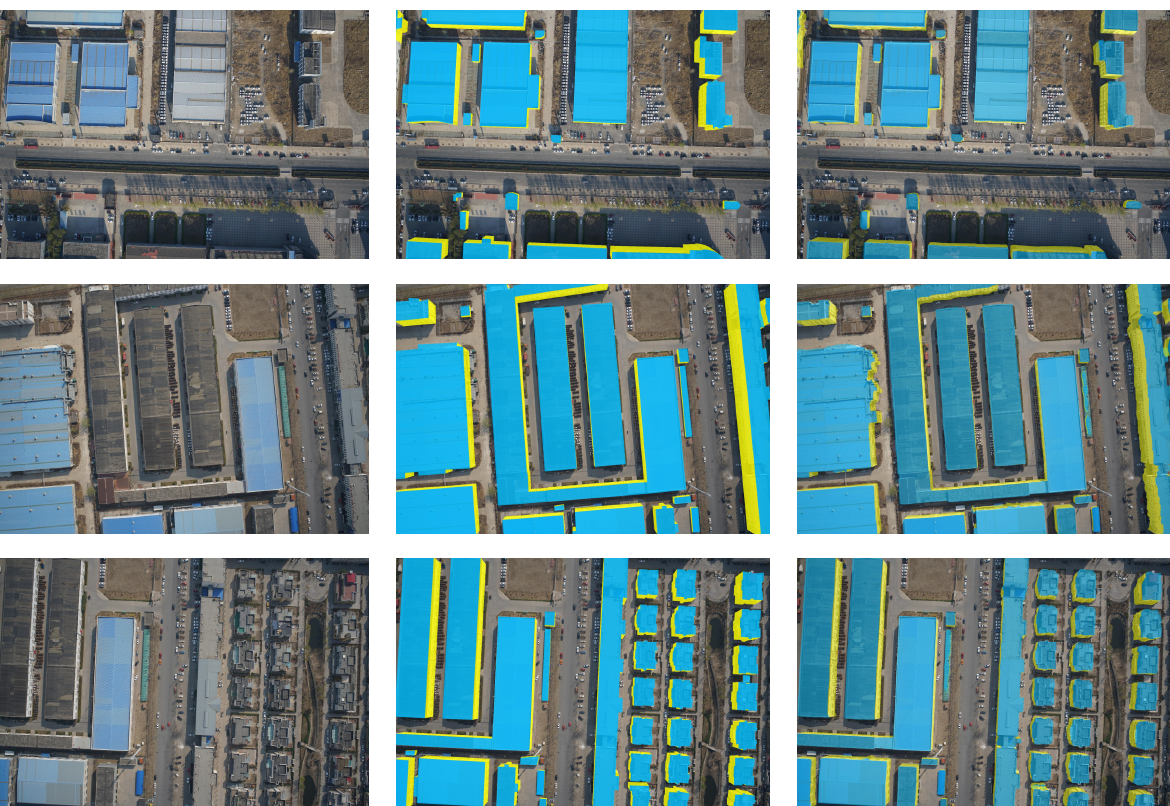
Figure 3. Samples of the reconstructed 3D buildings, which were projected on to the original aerial images. Left: the original aerial images, middle: the original aerial images covered with the projection masks of the building ground truth, right: the original aerial images covered with the reconstructed 3D building masks from our method. The light-cyan masks color the roofs and the light- yellow masks color the facades of the